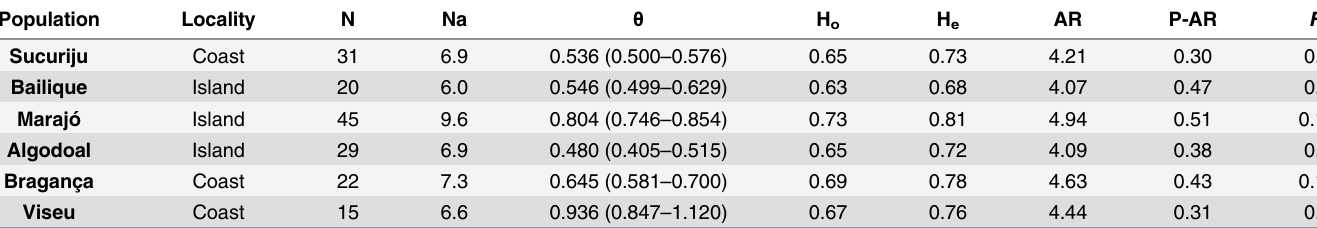
Table 1. Sample size and standard genetic diversity measures for each sampled locality of Rhinella marina